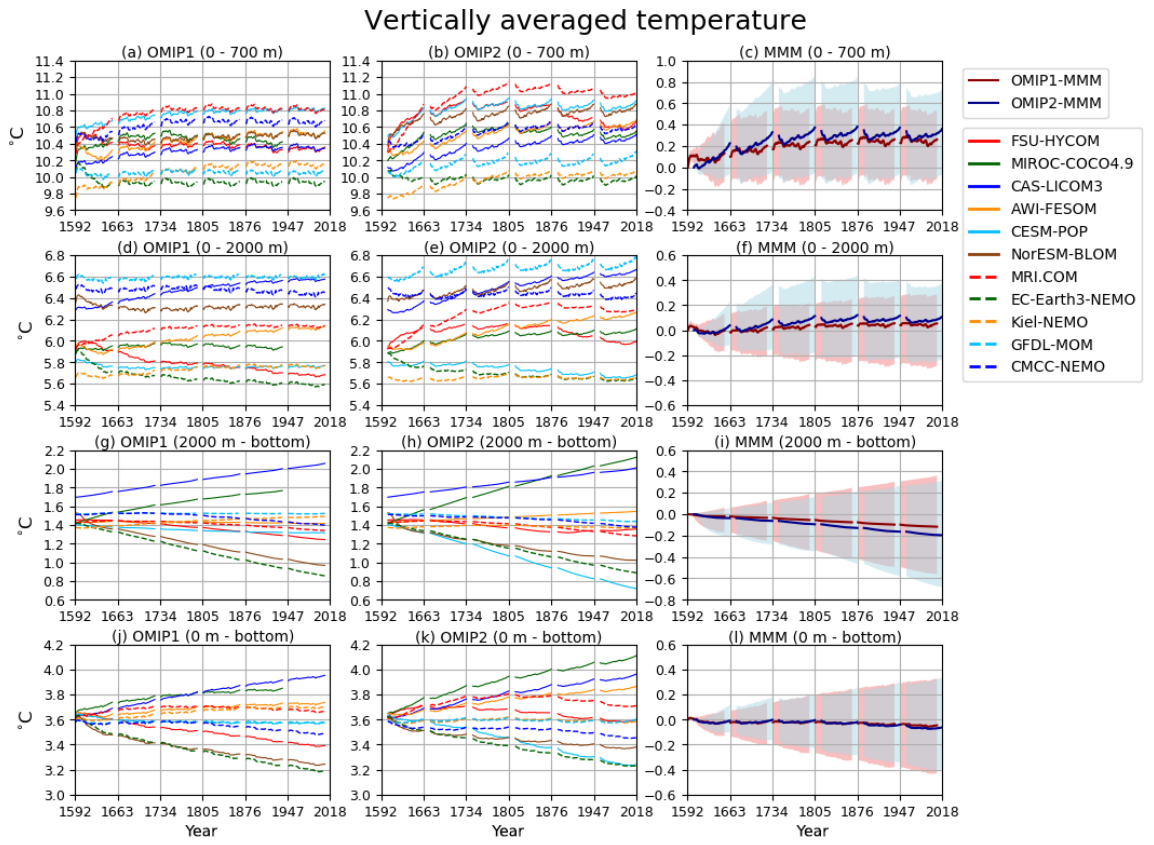
Figure 2. Drift of annual mean, global mean vertically averaged temperatures (units in ◦ C) for four depth ranges (a–c) 0–700m, (d–f) 0– 2000m, (g–i) 2000m–bottom, (j–l) 0m–bottom. (a, d, g, j) OMIP-1, (b, e, h, k) OMIP-2, and (c, f, i, l) multi-model ensemble mean (lines) of deviations from the annual mean of the initial year of the simulation by each model and spread defined as the range between maximum and minimum (shades) of OMIP-1 (red) and OMIP-2 (blue). See Figs. S1 and S2 for a closer look at individual